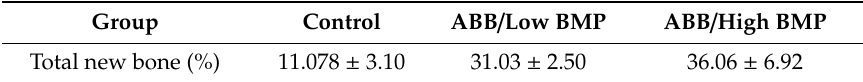
Table 1. Histomorphometric analysis of new bone formation